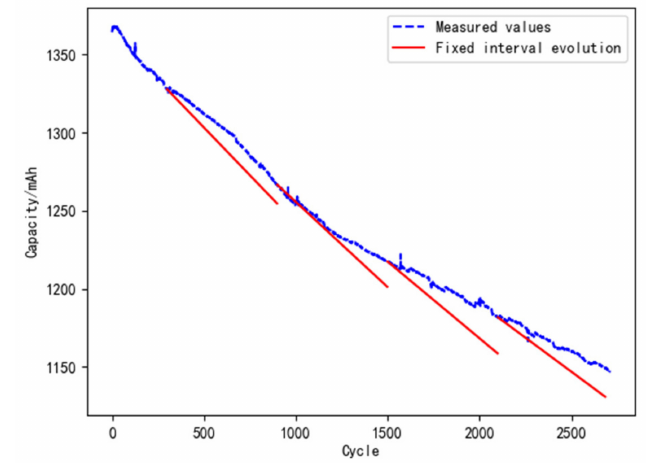
Figure 12. Model evolution with fixed